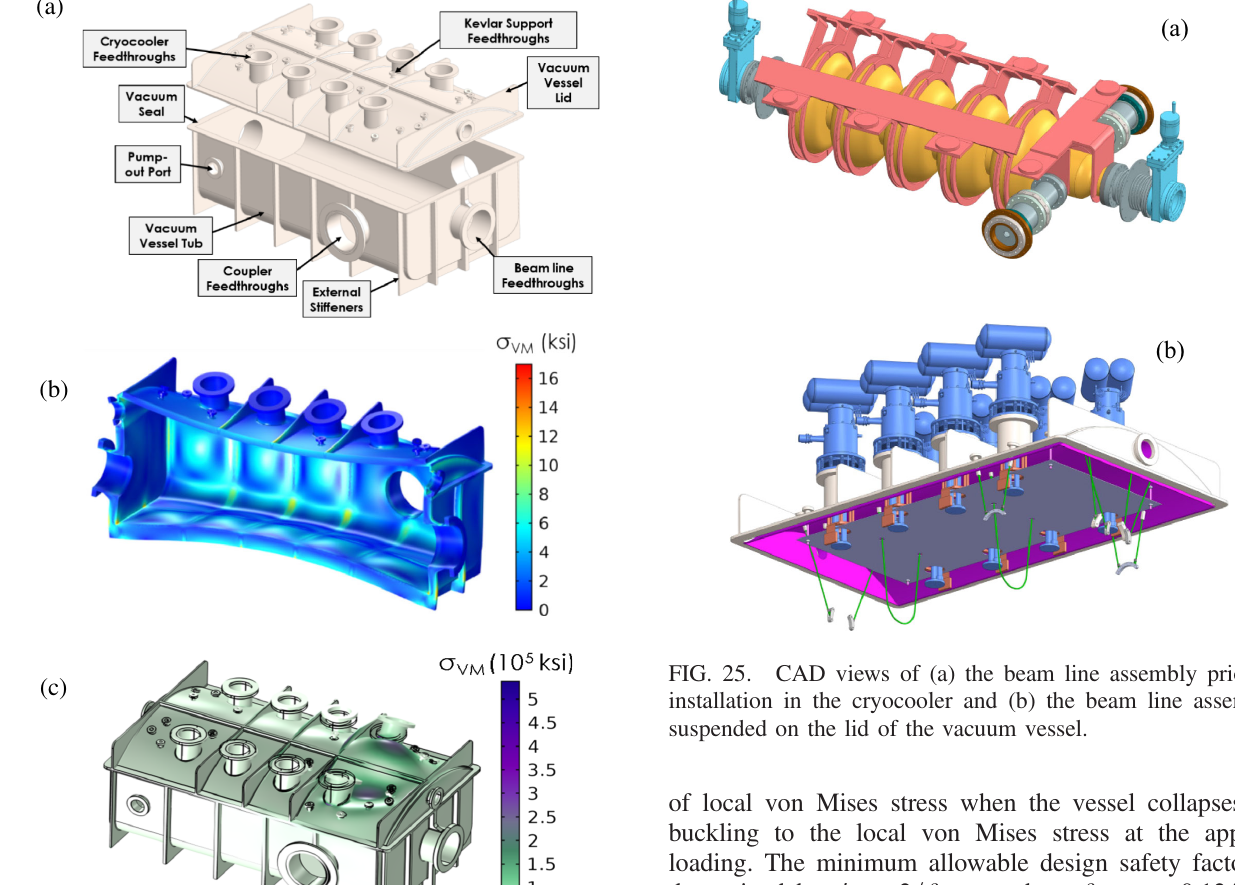
(130 times) cryostat deformations in Fig. 24(b) indicate that the largest displacements occur at the top and bottom of the vacuum vessel but do not exceed 1 mm in amplitude.